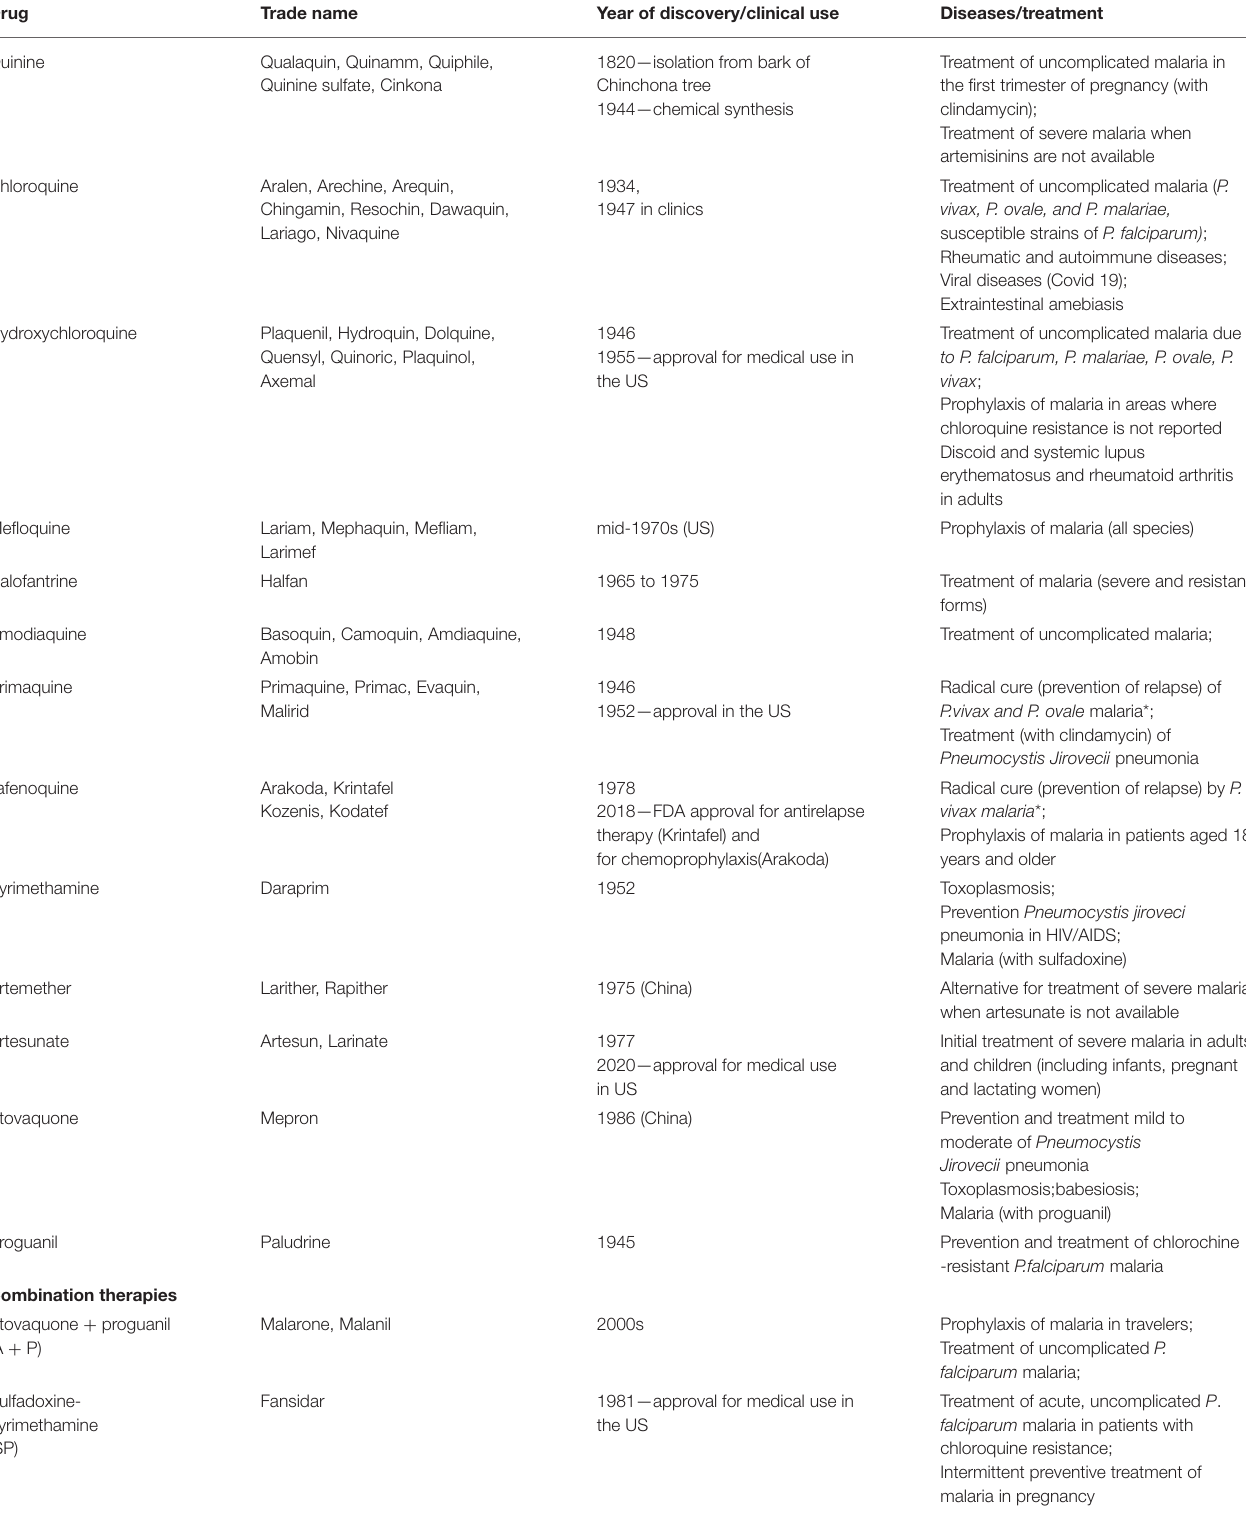
TABLE 1 | Commonly-used antimalarial drugs (2–4,